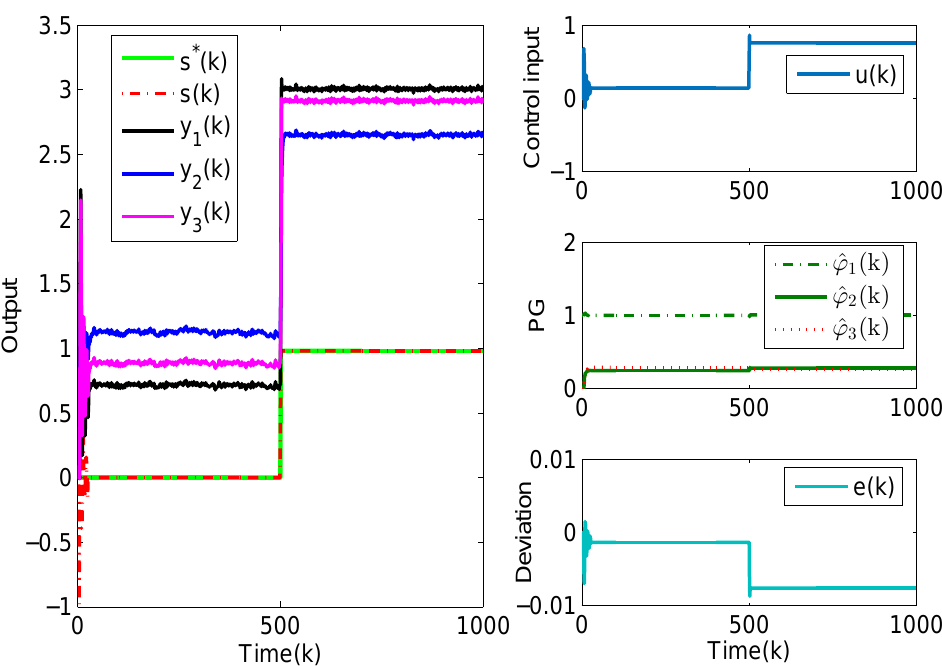
Figure 7. The curves of PG estimation values, control input, deviation, and outputs with l =